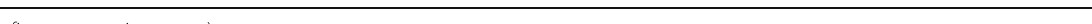
(See figure on previous page.) Fig. 2 The effects of combination of TD198946 and BMP-2 on chondrogenic pellet culture. a Macroscopic views of pellets treated with 50 ng/mL BMP-2 alone (Left panels) and combination of 10 nM TD198946 and 50 ng/mL BMP-2 (Right panels) at day 14. Scale bars = 1 mm. Histological images for Safranin-O, IHC for type I and II collagen at day 14. Scale bars = 500 μ m (Low magnification: upper panels) and 100 μ m (High magnification: left and right panels). Left: high magnification view of central zone of pellet. Right: high magnification view of surface zone of pellet. High magnification panels are magnified images of the specific zone represented by the square on the low magnification view. b Quantitative area measurement of type I collagen and type II collagen. ( n = 3) Mean ± SD, *: p < 0.05. c Measurement of pellet size (mm2). ( n = 5). Mean ± SD, *: p < 0.05 (D): sGAG content of cultured pellets at day 14. (Vehicle + 50